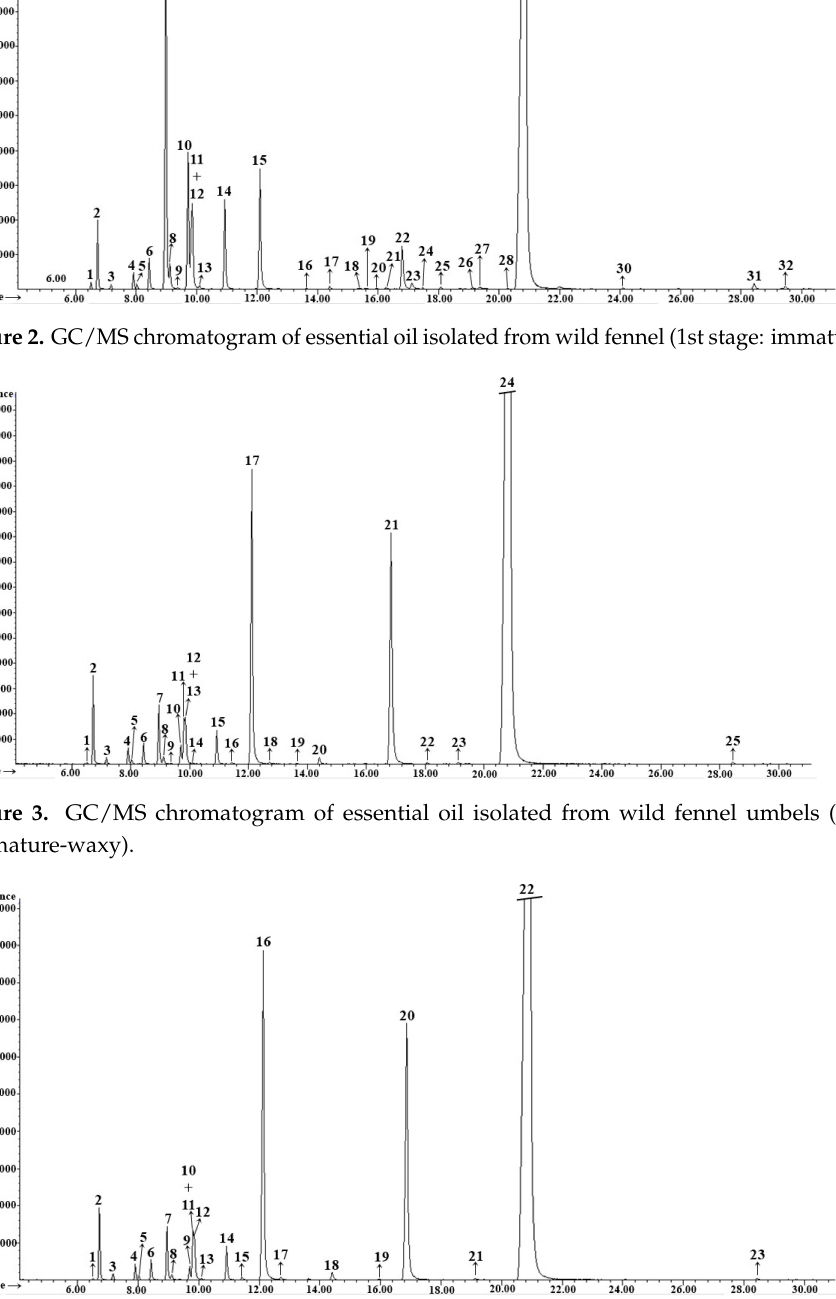
Figure 4. GC/MS chromatogram of essential oil isolated from wild fennel umbels (3rd stage: mature- fully